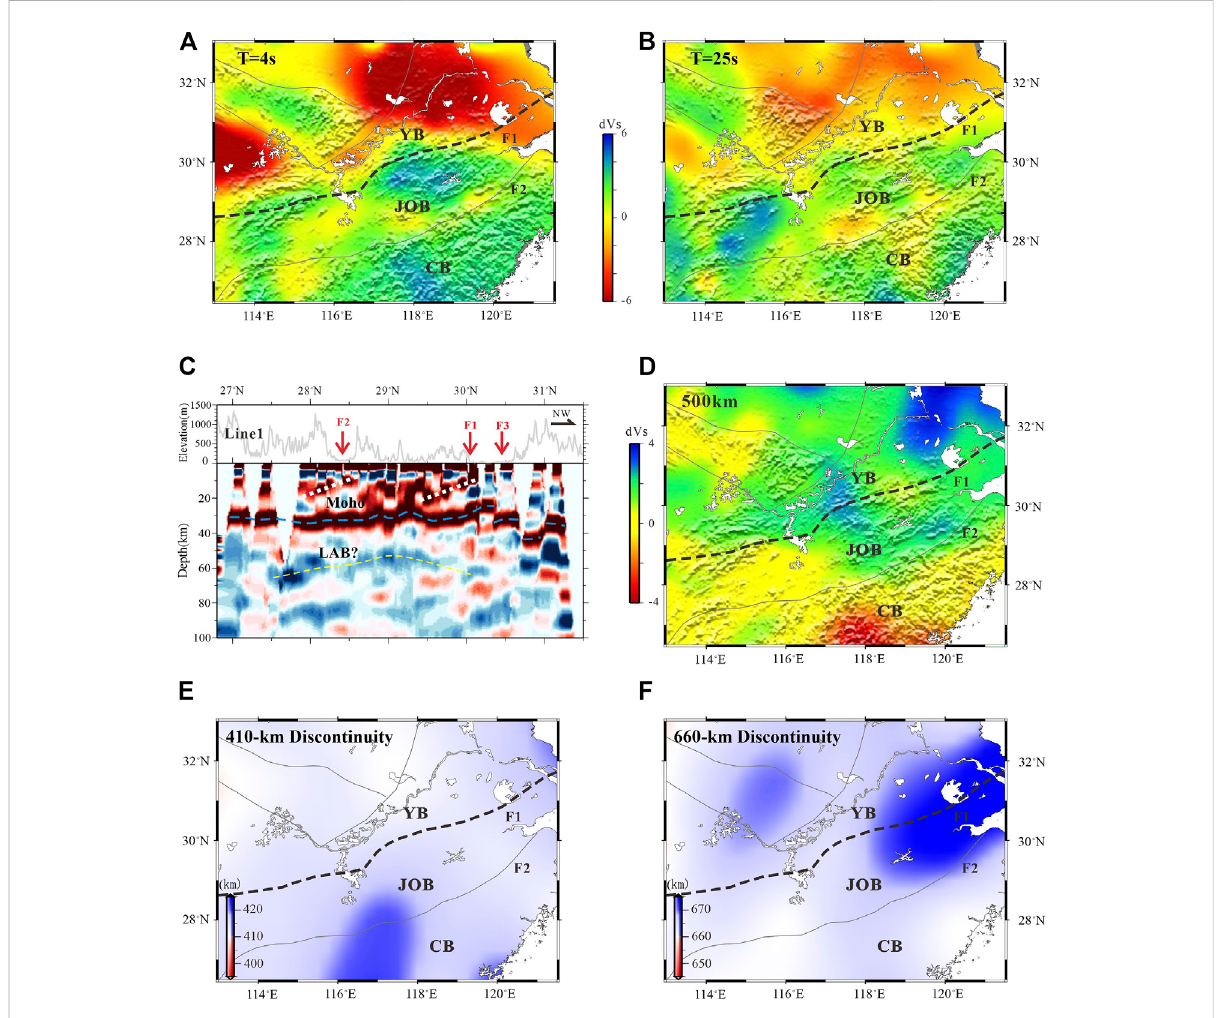
FIGURE 9 Rayleigh wave phase velocity perturbation at periods of 4 s (A) and 25 s (B) (Ma et al., 2022). Receiver function CCP stacking result (C) (Ye et al., 2019). S-wave velocity (Vs) tomography at the depth of 500 km (D) (Huang et al., 2021). Topography of the 410-km (E) and 660-km discontinuity (F) (Han et al., 2020). Labels are the same as in Figure